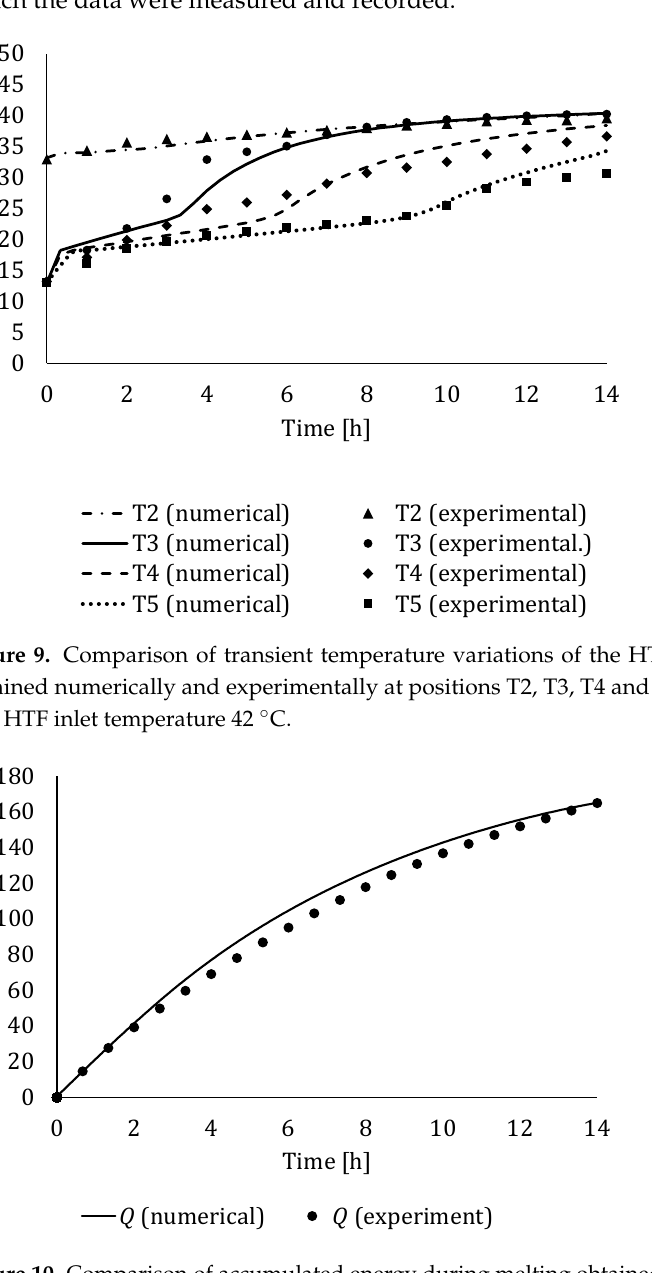
Figure 10. Comparison of accumulated energy during melting obtained numerically and experi- mentally for HTF flow rate 620 l/h and HTF inlet temperature 42 °C.